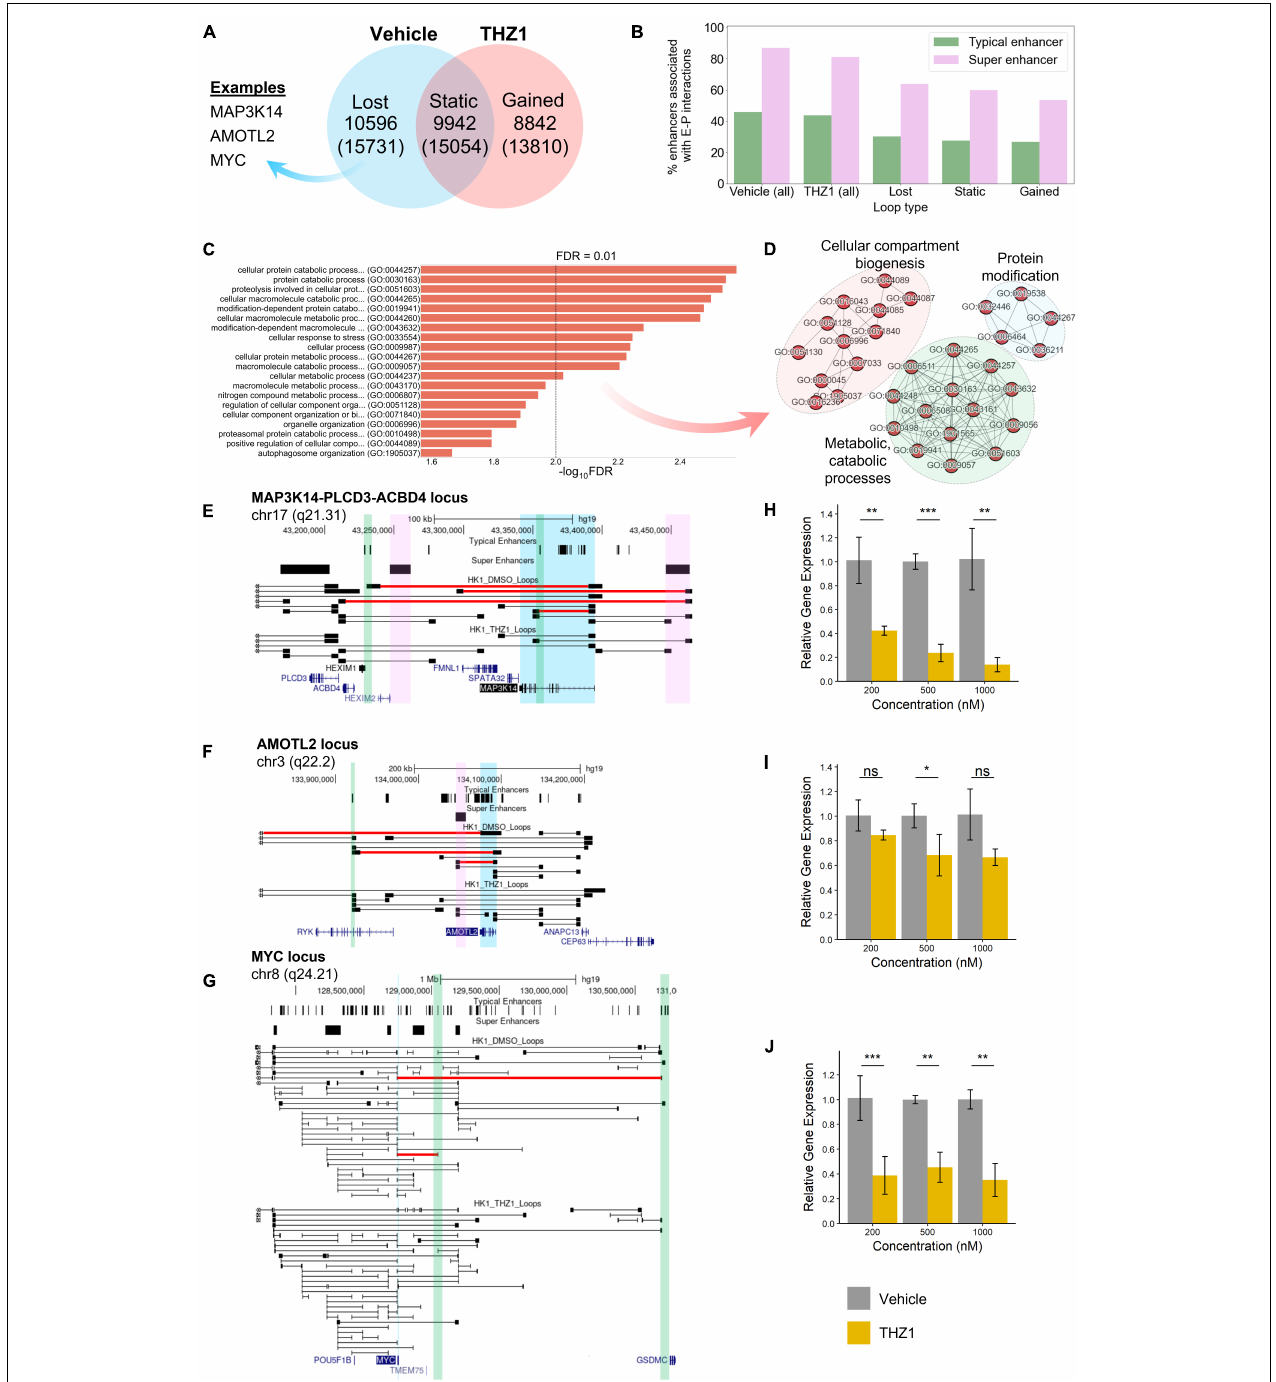
FIGURE 5 | (A) Functional analysis of HK1 chromatin interactome following treatment with CDK7 inhibitor THZ1. (A) Venn diagram representing the number of loops lost after THZ1 treatment compared with DMSO (vehicle) treatment, unchanged between treatments, and gained after treatment. The number of genes with promoter regions within 15 kb of the respective loop anchors is shown in the parentheses below. (B) Anchor occupancy characteristics of super enhancers and typical enhancers predicted from H3K27ac ChIP-Seq. A higher percentage of super enhancers is associated with enhancer–promoter loops, compared with typical enhancers. (C) Top 20 overrepresented GO-Slim Biological Process terms by false discovery rate (FDR), derived from the set of protein-coding genes with net lost loops following THZ1 treatment. (D) Network representation of predominantly enriched GO term clusters. (E–G) Looping structure of MAP3K14, AMOTL2, and MYC loci. Lost loops following THZ1 treatment are shown in red. Gene of interest is highlighted in blue. Select super enhancers with lost loops to promoters are highlighted in pink. Select typical enhancers with lost loops to promoters are highlighted in green. (H–J) RT-qPCR results for MAP3K14, AMOTL2, and MYC, respectively, following 24 h of vehicle or THZ1 treatment (* p ≤ 0.05, ** p ≤ 0.01, *** p ≤ 0.001).